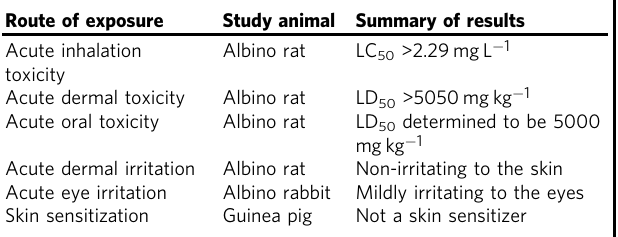
Table 2 Toxicological pro fi le of copper – glass ceramic powder in animal studies conducted in accordance with US EPA